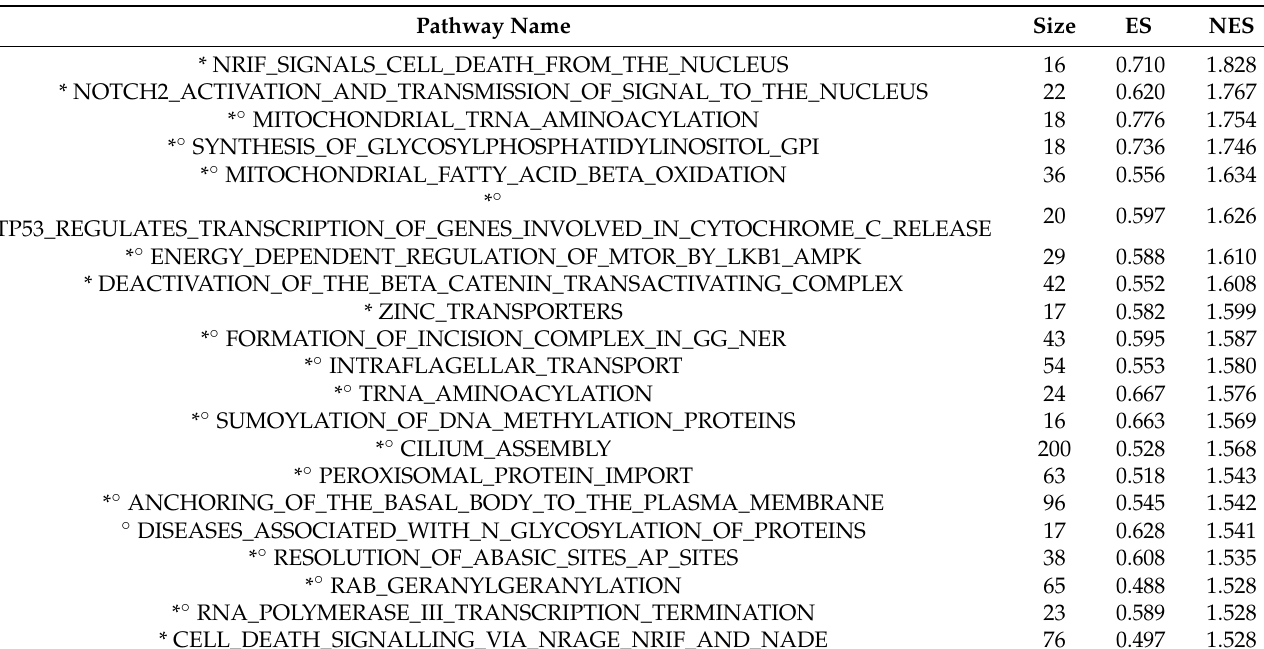
Table 4. GSEA (gene set enrichment analysis) analysis of cytogenetic group A vs. CTRL (1058 samples; Analysis I). Reactome pathways with normalized enrichment score (NES) >